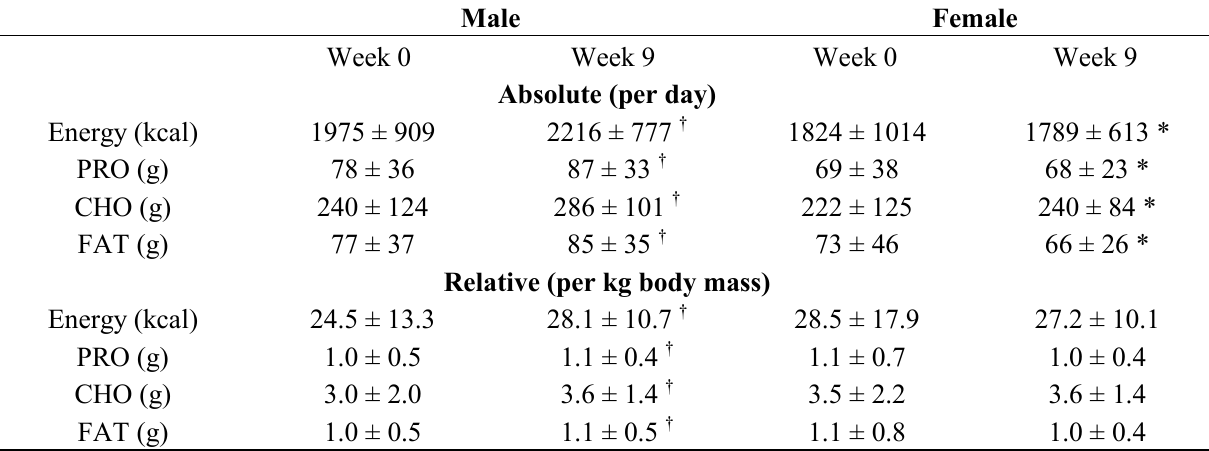
Table 2. Patterns of dietary intake before and during basic combat training based on FFQ 1